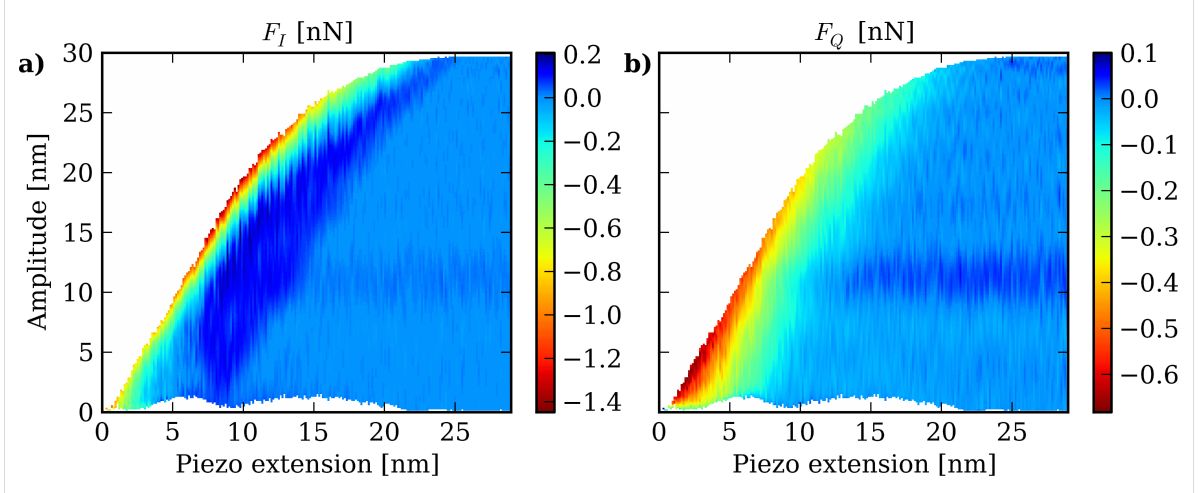
Figure 7: F I ( h , A ) and F Q ( h , A ) maps reconstructed from an ImAFM approach measurements on a PS surface. The z -piezo extension corresponds to a relative change of the probe height h above the sample surface.